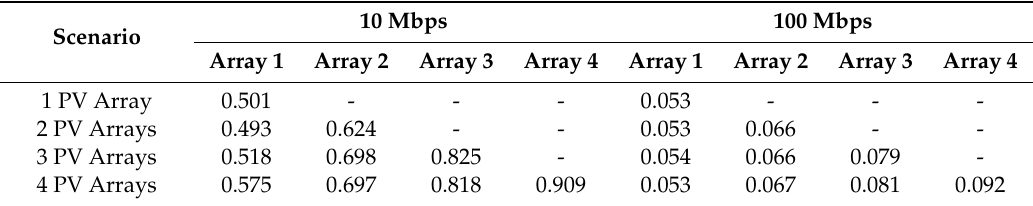
Table 8. Internet Protocol (IP) end-to-end delay (ms) for fixed mounted PV arrays (without sun trackers) with di ff erent link